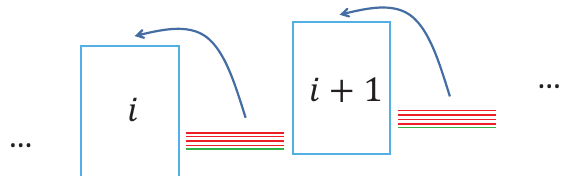
Figure 7: The fusion strategy of dealing with 3D data and 2D image data captured at the different frequencies. The blue rectangles denotes the CCD images, and the green and red vertical lines indicate the 3D profiles. The i and i + 1 represent the image indexes. The green lines mean that the CCD camera and 3D camera exposure at the same time.